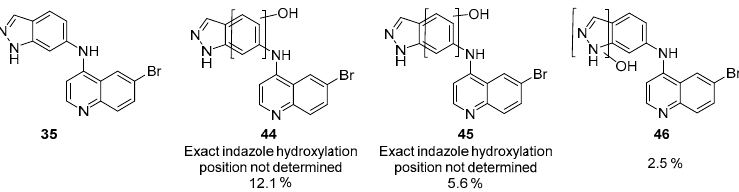
Figure 5. Compound 35 and corresponding metabolites ( 44–46 ) identified along with percentage abundance ordered by retention time (see Supplementary Materials).